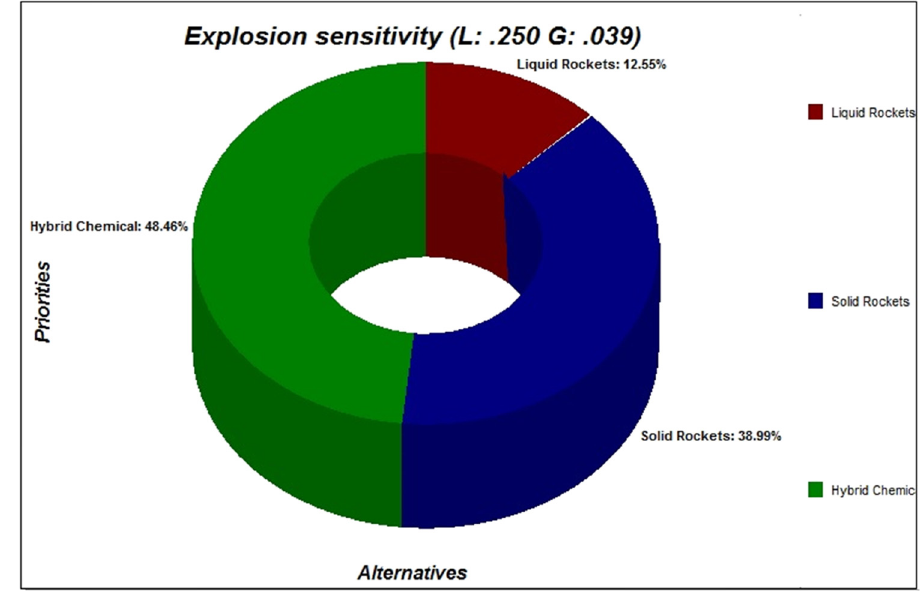
Figure 5: Priorities of the alternatives with respect to the expulsion sensitivity sub - criterion.